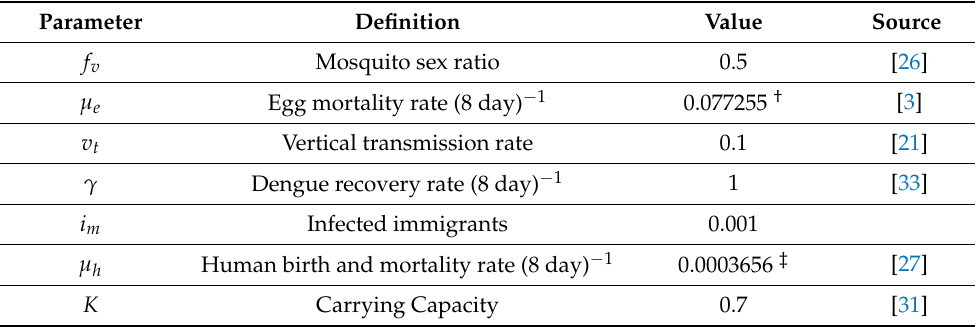
Table 1. Constant model parameters. † these values were obtained from the literature as daily rates and were converted to 8 day − 1 . ‡ converted from annual